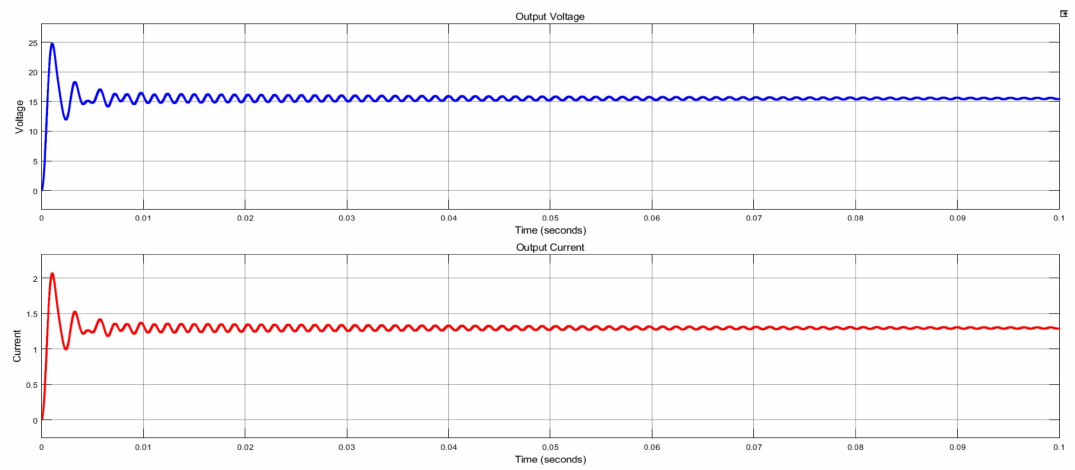
Figure 11. Voltage and current measurement for EVs.